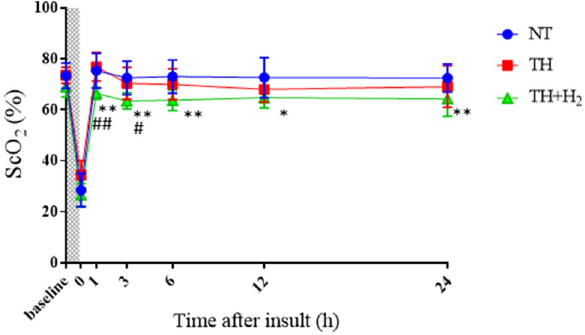
Figure 6. Cerebral hemoglobin oxygen saturation (ScO 2 , %) at the end and at 1, 3, 6, 12, and 24 h after hypoxic- ischemic insult in normothermia (NT, n = 10), therapeutic hypothermia (TH, n = 8), and TH with hydrogen gas inhalation (TH + H 2 , n = 8) groups. * p < 0.05, ** p < 0.01 vs. the NT group; # p < 0.05, ## p < 0.01 vs. the TH group.